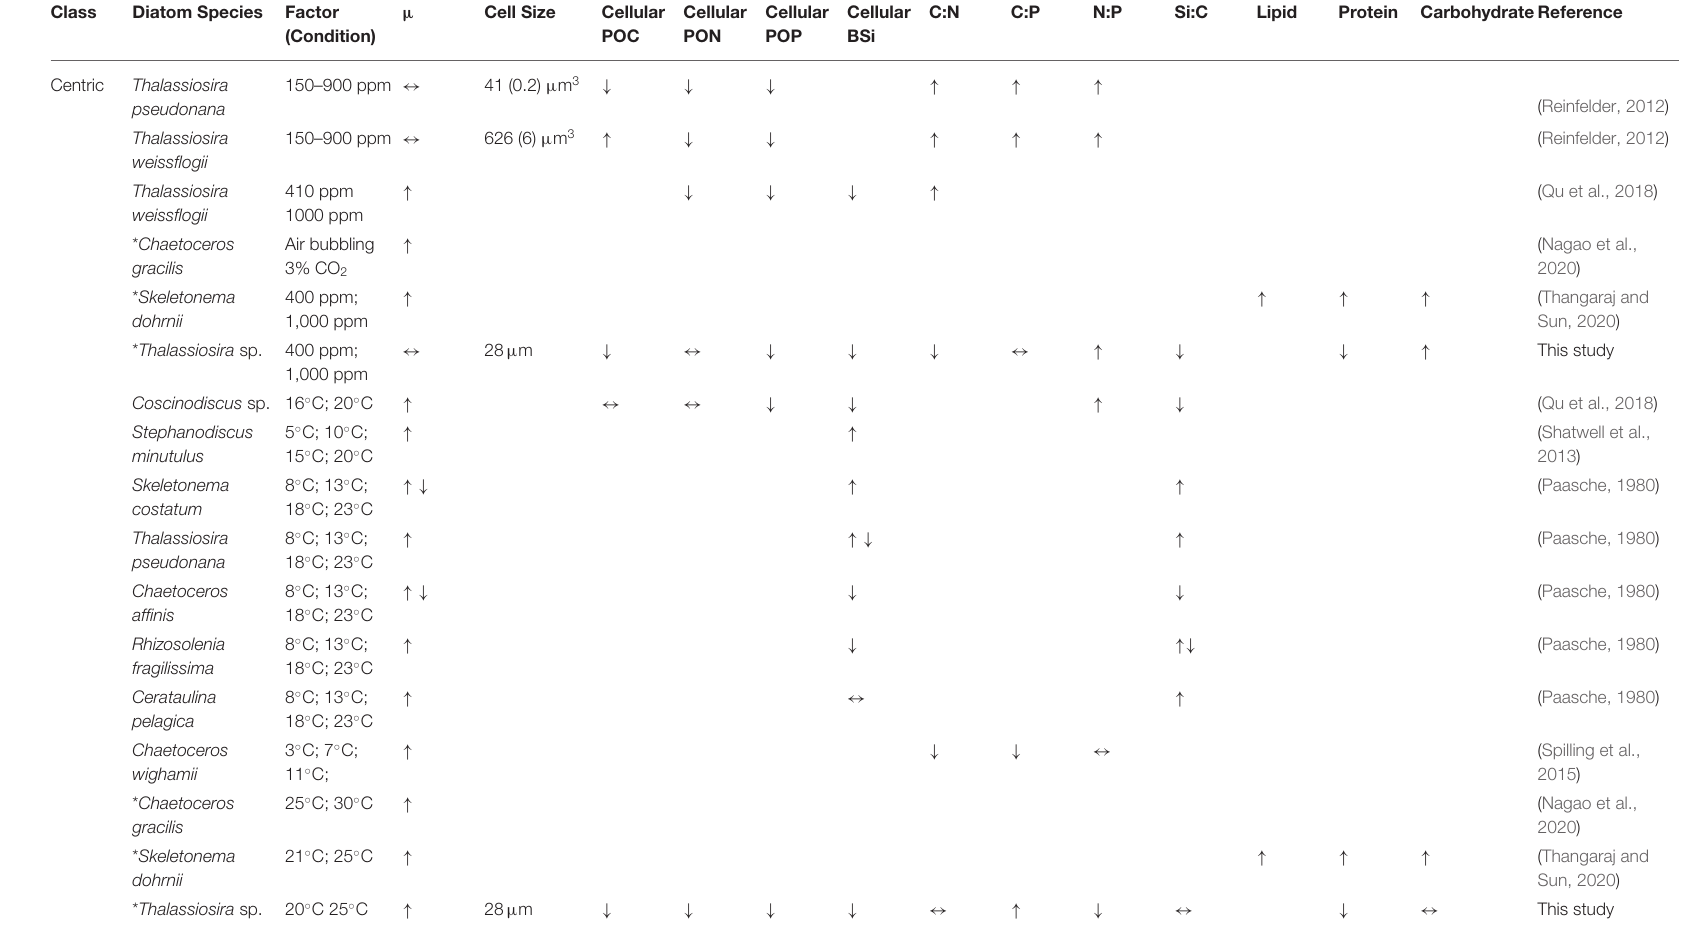
TABLE 1 | Response of diatoms to rising pCO 2 and elevated temperature summarized from published studies, considering incubation conditions in terms of growth rate ( µ ), cellular particulate organic carbon (POC) content, cellular particulate organic nitrogen (PON) content, cellular particulate organic phosphate (POP) content, cellular biogenic silica (BSi) content, the POC-to-PON ratio (C:N), the POC-to-POP ratio (C:P), the PON-to-POP ratio (N:P), the BSi-to-POC ratio (Si:C), the lipid content, the protein content, and the carbohydrate content. µ Cell Size Cellular Class Diatom Species Factor (Condition) POC